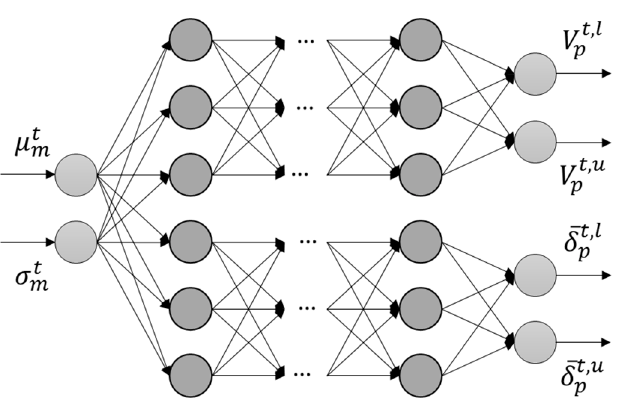
Figure 3. Schematic overview of the separated NN for the nodal voltage magnitudes and angles.